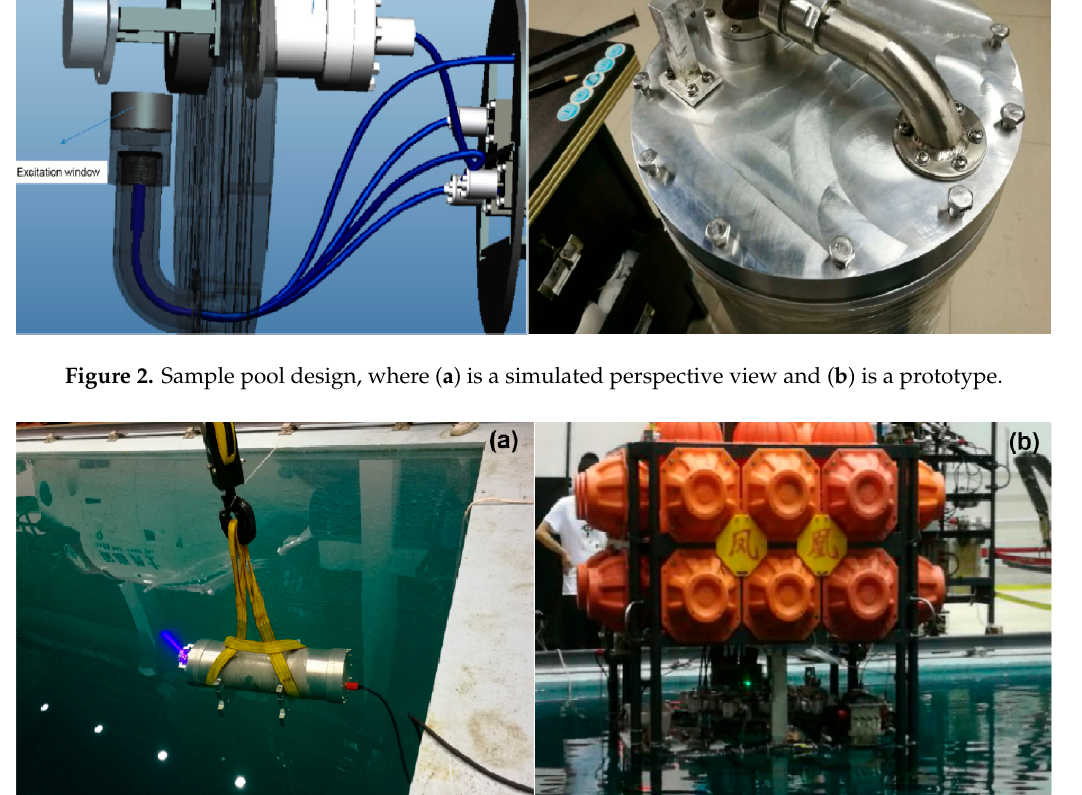
Figure 3. Real-time in situ detection with an LIF instrument.(a) The LIF instrument works in the pool and (b) The LIF instrument is carried on the Phoenix underwater work platform.